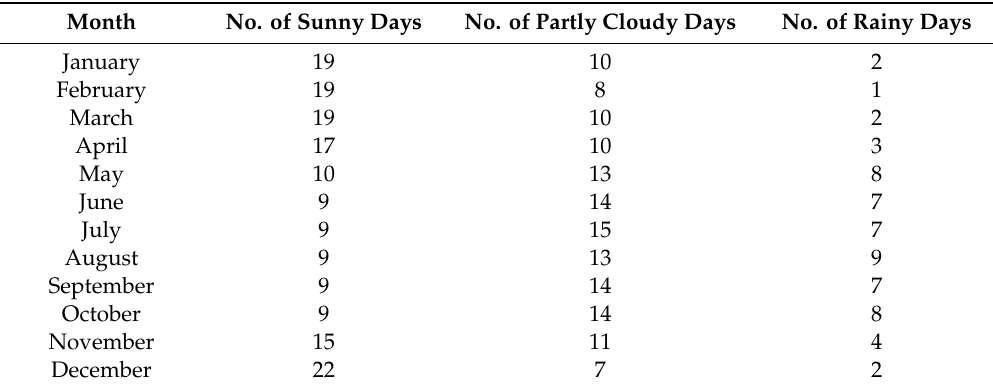
Table 4. Analysed numbers of days in every month of a year for di ff erent weather conditions.